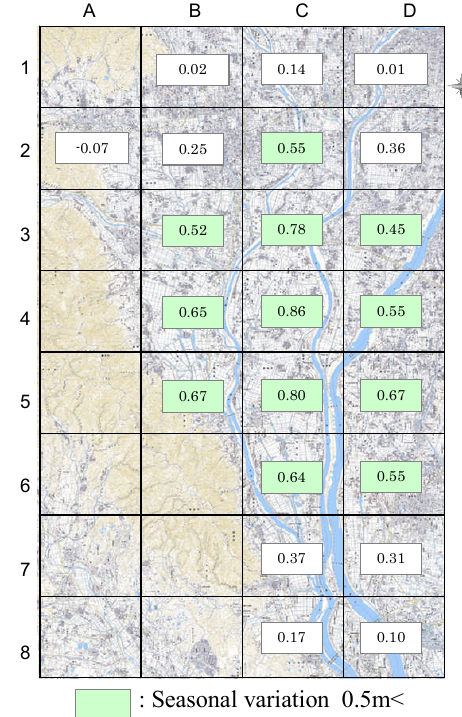
Figure 9. Seasonal variation of average value of groundwater level (1989–2006).